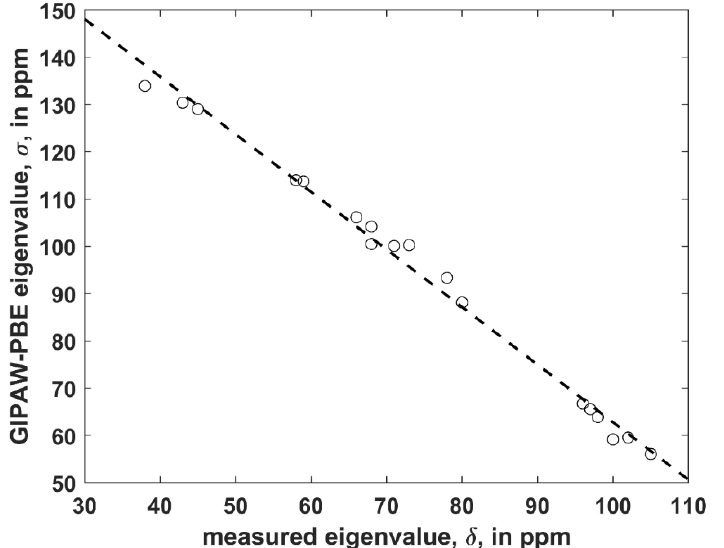
Figure 2. The linear regression model of the 13 C SSNMR data described in the text (the dashed line is σ = −1.218 × δ + 184.6 ppm).